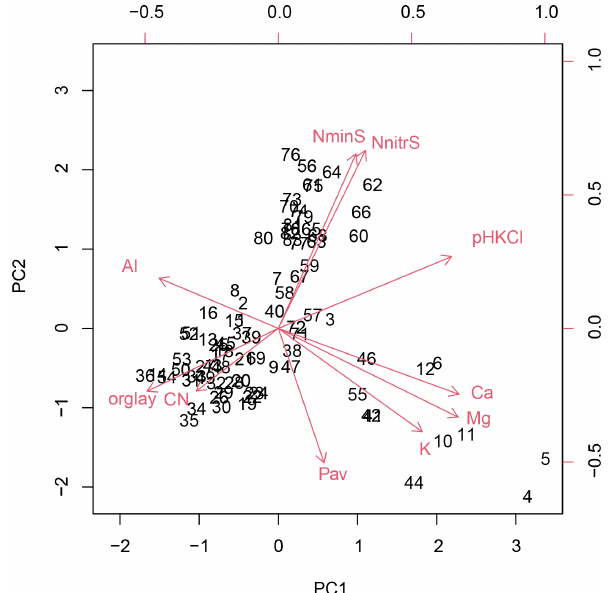
Figure B1. Principal component analysis of the soil properties of 83 study plots (Loja transect and Napo transect); PC1 and PC2 explained 37.4% and 26.1% of variance, respectively.